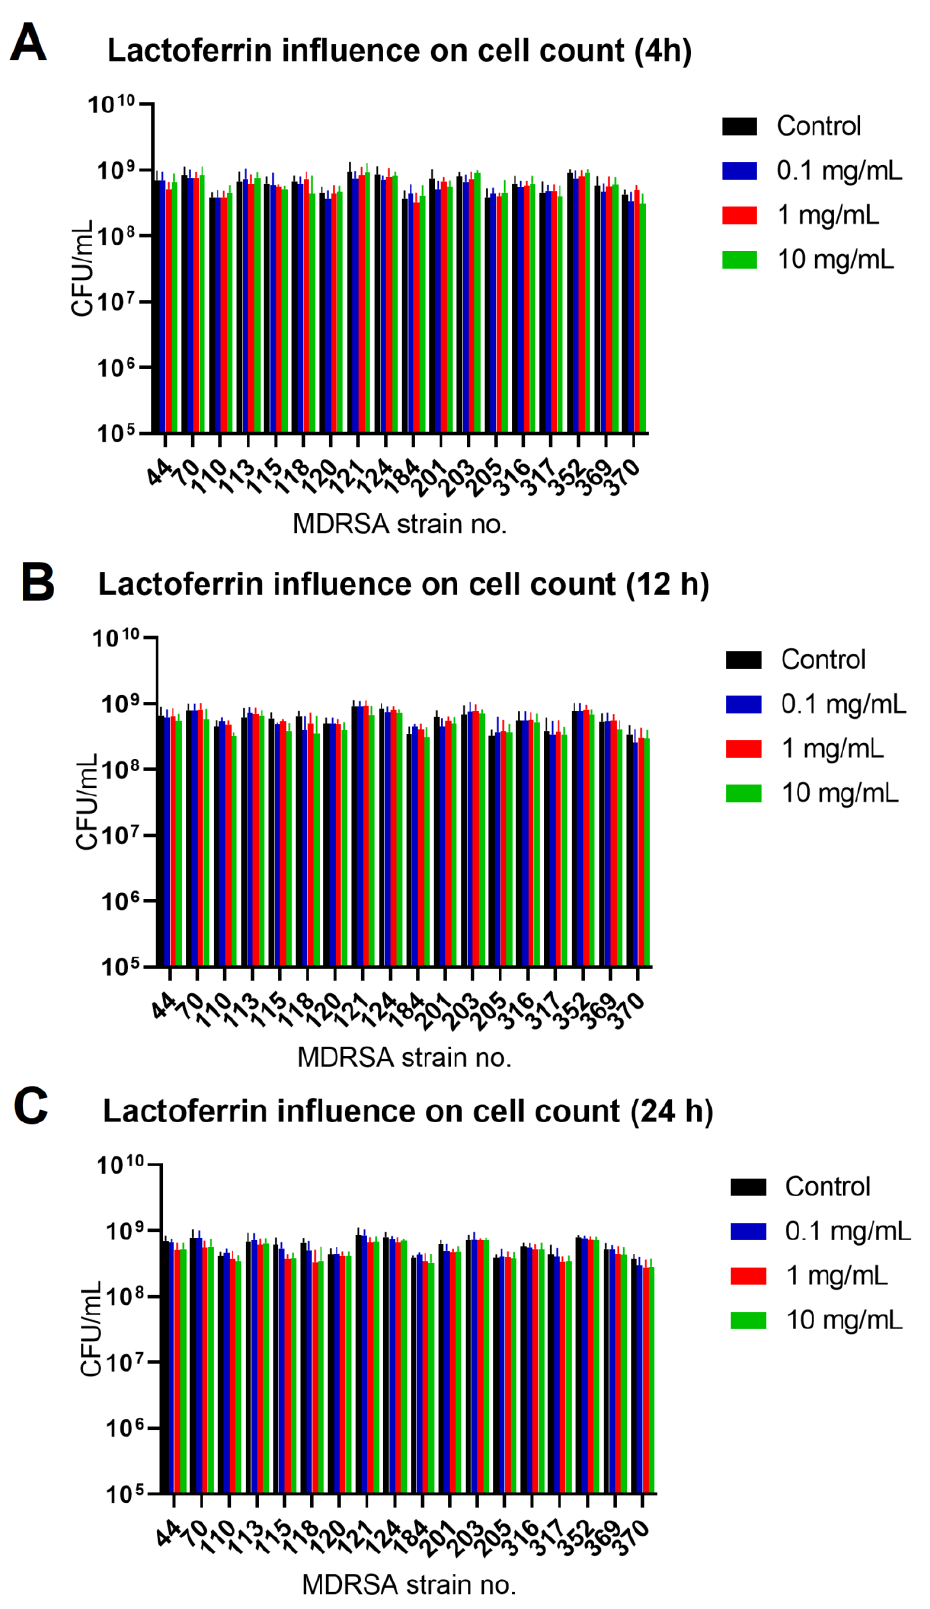
Figure 4. Influence of lactoferrin (0.1 mg/mL, 1.0 mg/mL and 10 mg/mL) on MDRSA biofilm CFU/mL count after 4 h ( A ), 12 h ( B ) and 24 h ( C ) of incubation. Mean of triplicates, with error bars representing SD. Statistical analysis performed using t -test showed no significance.